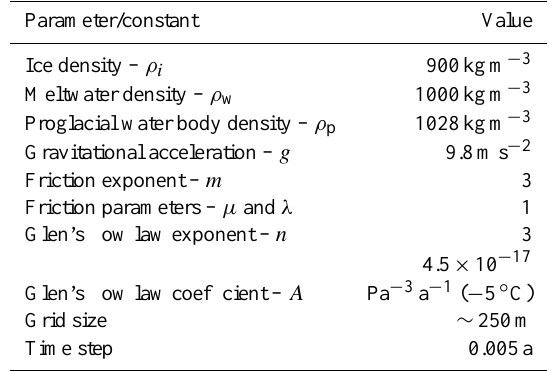
Table 2. List of parameters and constants used for running the